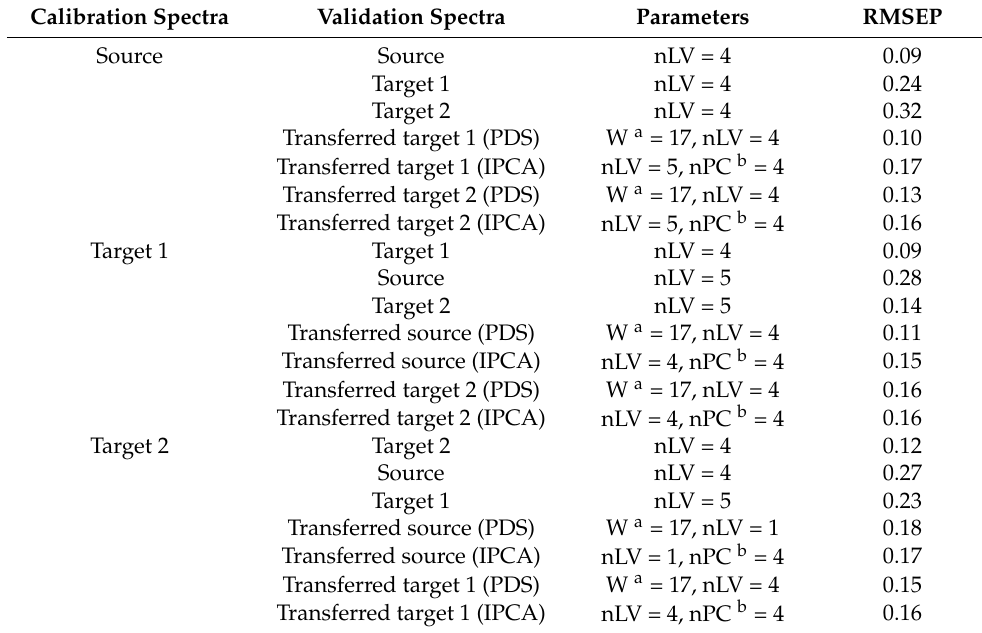
Table 2. Calibration transfer results obtained by PDS and IPCA for dataset 2.